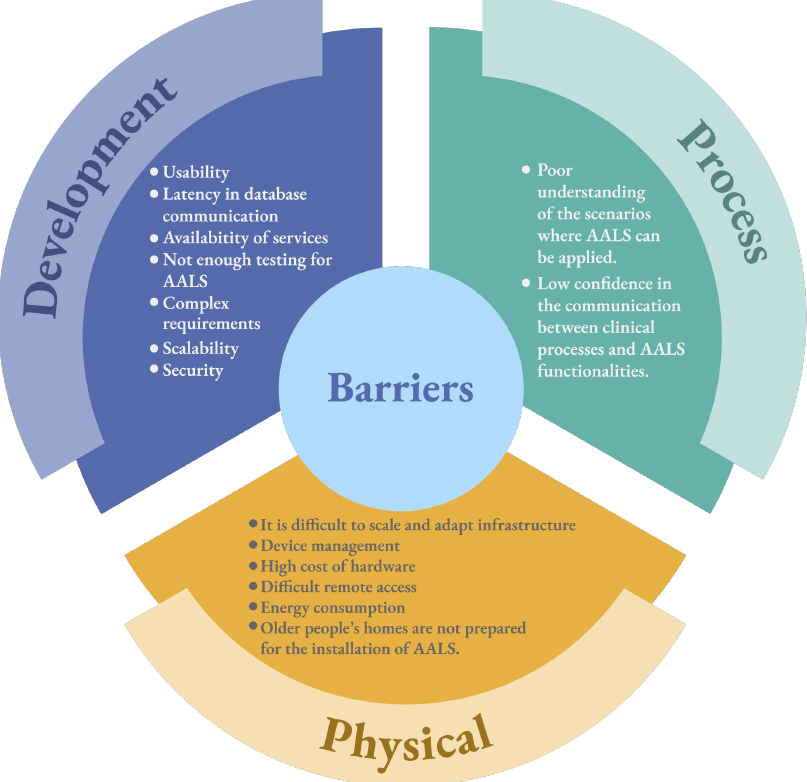
Figure 7. Description of the detected barriers classified by the system